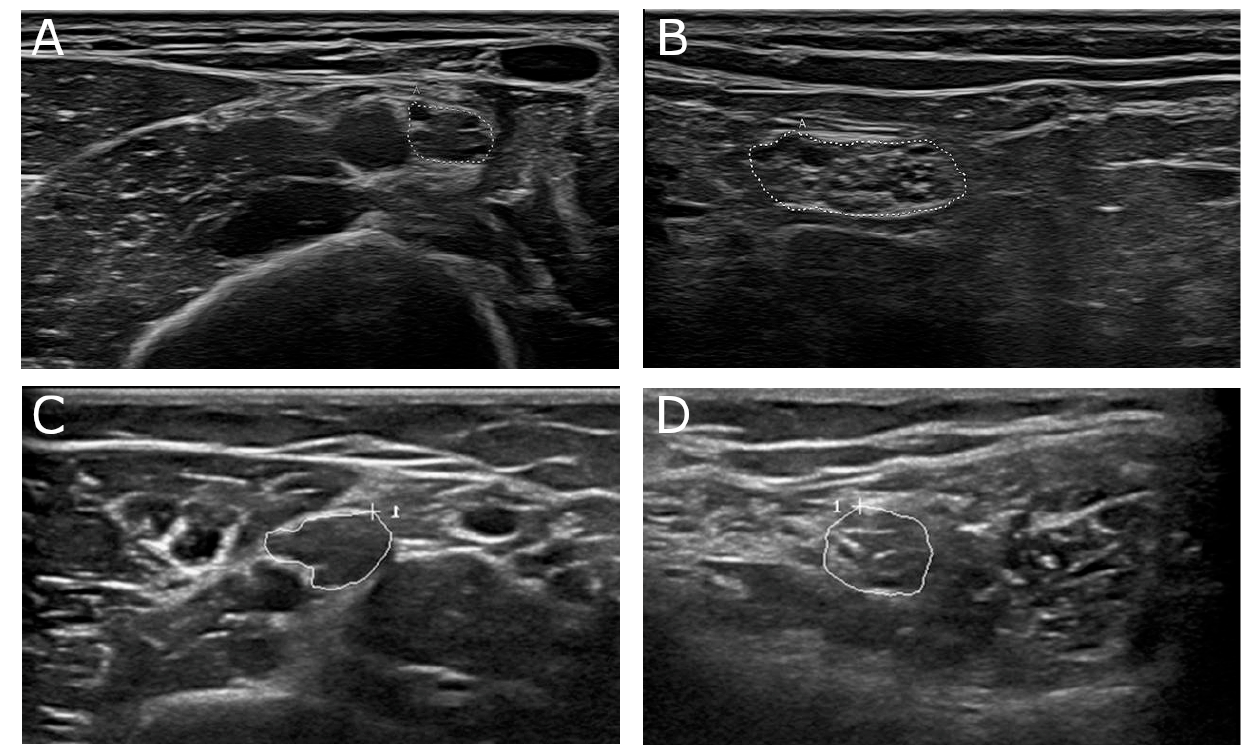
Figure 4. ( A , B ) 68-year-old male patient with genetically proven adrenomyeloneuropathy, an adult form of adrenoleukodystrophy. Nerve conduction studies showed a demyelinating damage pattern. In nerve ultrasound focal nerve enlargement was detected with a UPSS of 7 points. ( A ) Median nerve at upper arm segment (cross-sectional area (CSA) 15 mm², normal value 12 mm²). ( B ) Tibial nerve at popliteal fossa (CSA 51 mm², normal value 33 mm²). ( C,D ) 16-year-old female patient with juvenile form of metachromatic leukodystrophy. Focal nerve enlargement was seen in median nerve ( C , CSA 20 mm²) at proximal nerve sites next to normal nerve segments in other nerves, i.e., tibial nerve ( D , CSA 23 mm²). Areae enclosed by the discontinuous points in picture A and B depict CSA of the described nerve section, “A”means “area”. Areae enclosed by circles in pictures C and D depict CSA of the described nerve section, “+” shows curser position, “1” the count of measured areae.